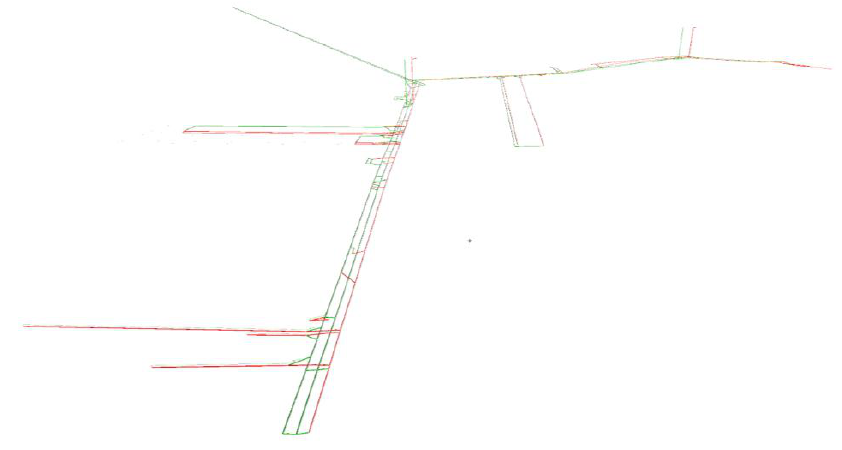
Figure 2. Mine ventilation three-dimensional (3D) model.